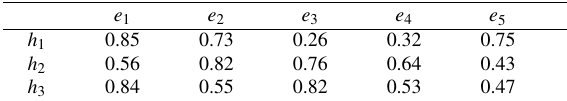
Table 4: Tabular representation of ( F , A )